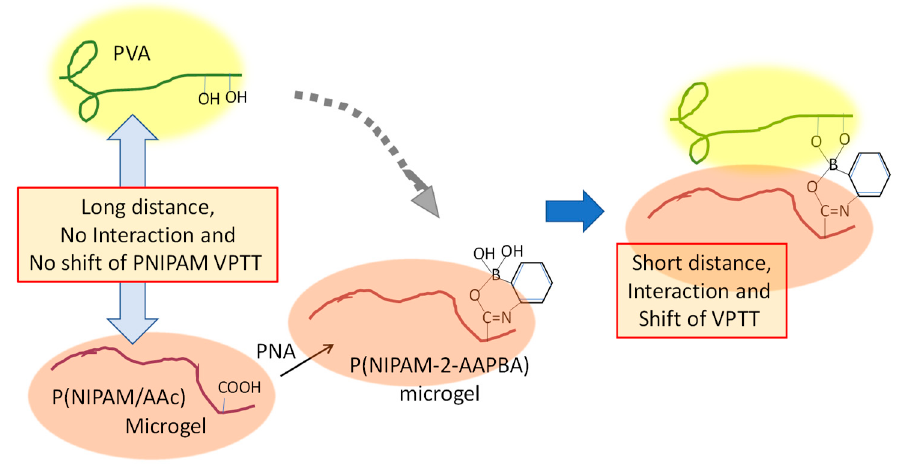
Figure 6. The forced pulling of PVA results in a decrease in VPTT f PNIPAM